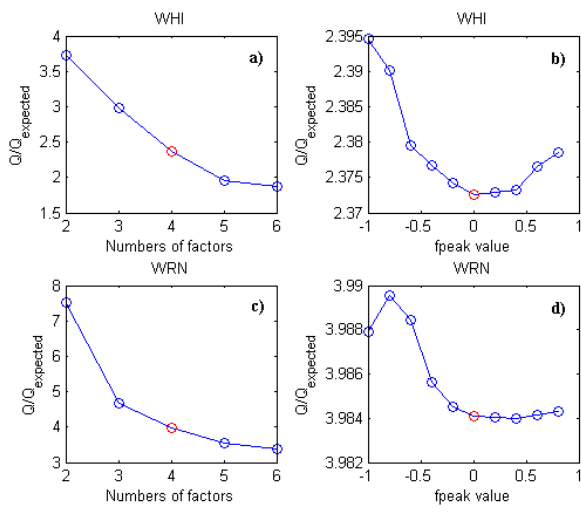
Fig. 3. Q/Q expected for Whistler Peak against (a) numbers of factors used, and (b) fpeak values for 4 factors. Q/Q expected for Raven’s Nest against (c) numbers of factors used, and (d) fpeak values for 4 factors. The red circles show the chosen factor solution.